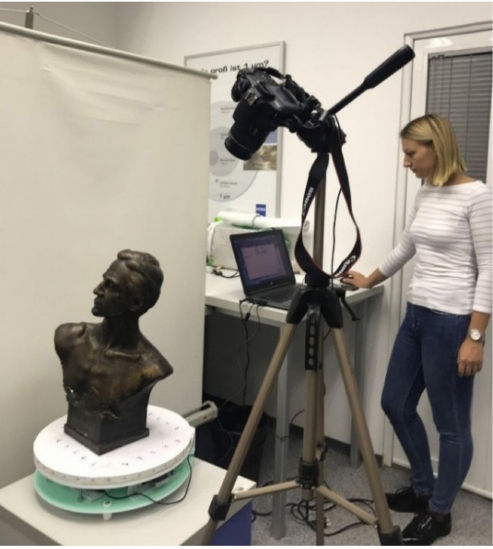
Figure 3. Setting up the elements during photographing in the laboratory.